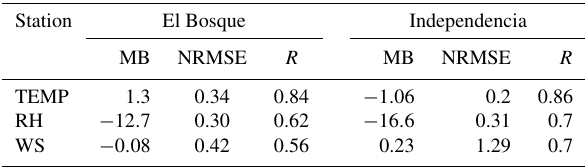
Table 2. Simulation scores – mean bias (MB), normalized root mean square error (NRMSE), and Pearson correlation ( R ) – for 2m temperature (TEMP), surface relative humidity (RH) and 10m wind speed (WS), 15 June to 15 July